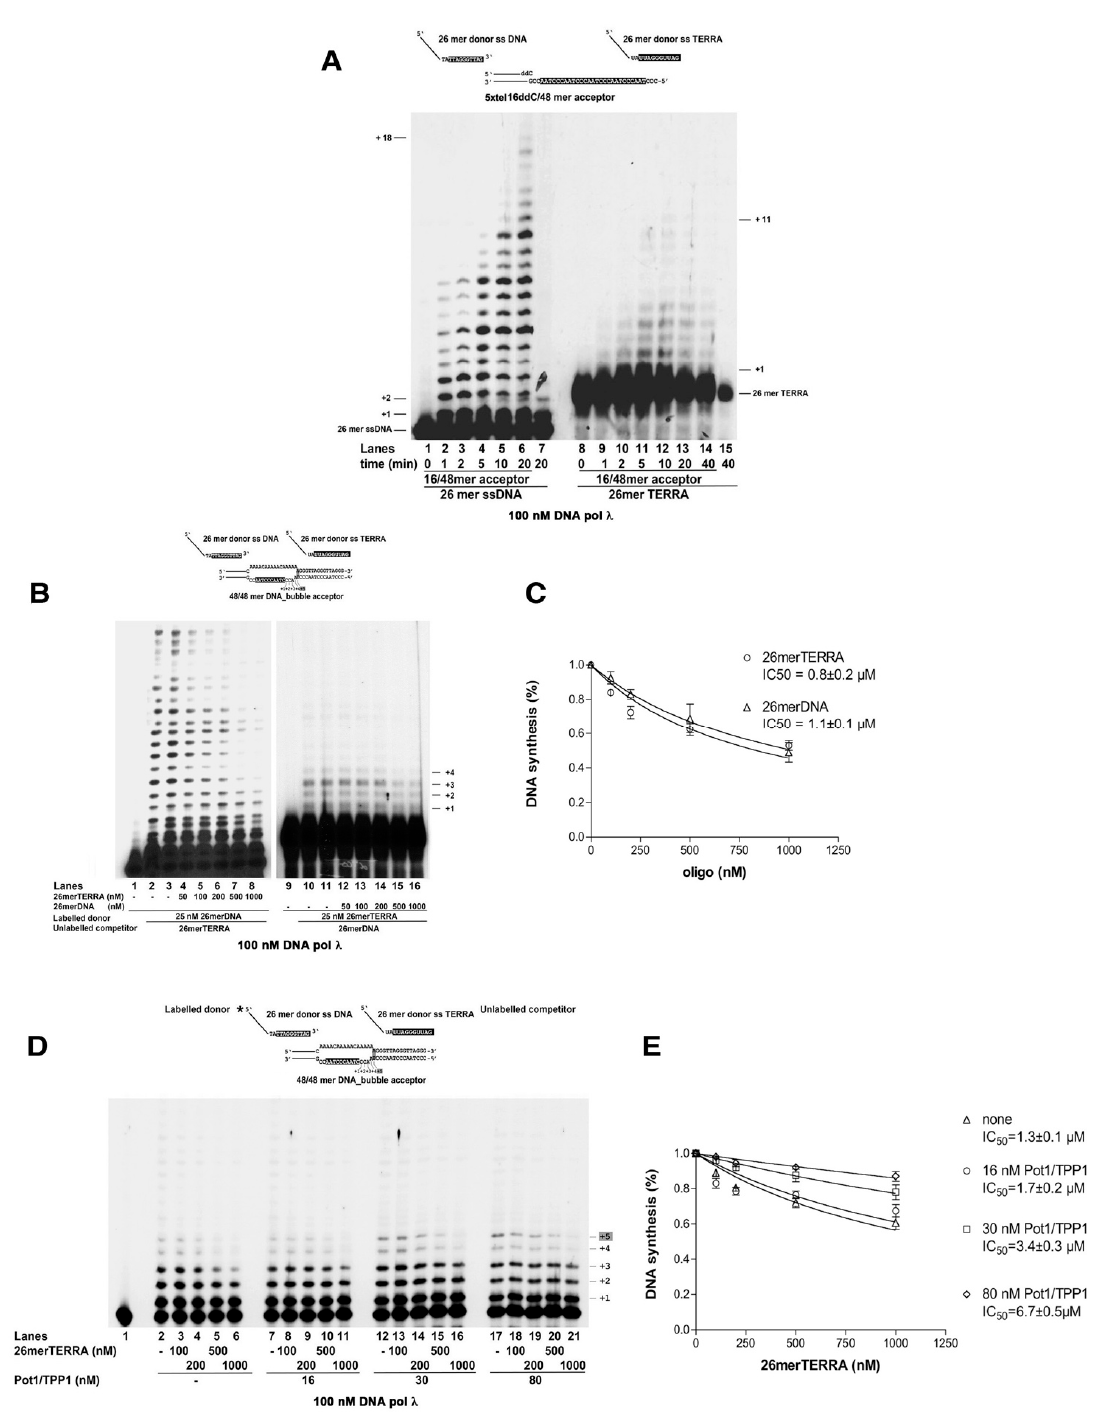
Figure 5. TERRA RNA represses the strand transfer activity by DNA polymerase λ and is counteracted by POT1/TPP1. ( A ) Time course of MMST synthesis by Pol λ with the 26 mer donor DNA (lanes 1–6) or the 26 mer TERRA donor RNA (lanes 8–14) and the 5xtel 16/48 mer acceptor template. Lane 7, reaction with the 26 mer donor DNA without the acceptor template. Lane 15, reaction with the 26 mer TERRA donor RNA without the acceptor template. ( B ) Titration of 26mer TERRA (lanes